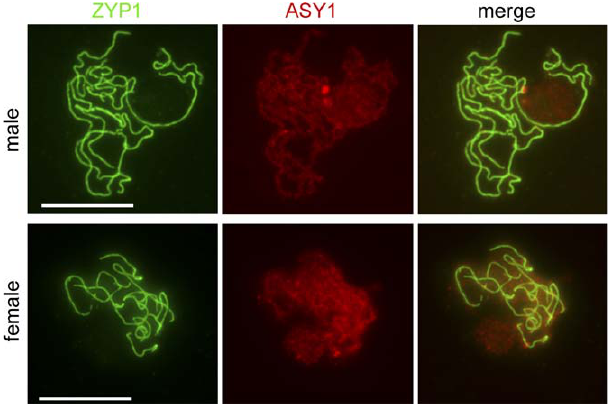
Figure 2. Coimmunolocalization of ASY1 (Red) and ZYP1 (Green) in Male and Female Meiocytes at Pachytene Stage Bar ¼ 10 l m.